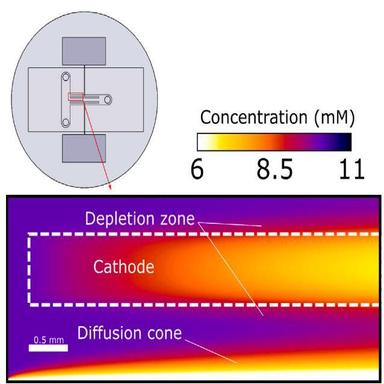
Result of the concentration field computed using the numerical model presented in Appendix A. Only the electrode onset at the MFC inlet is presented to match the imaging data. The red rectangle in the MFC insert indicates the position. The white rectangle represents the electrode position.